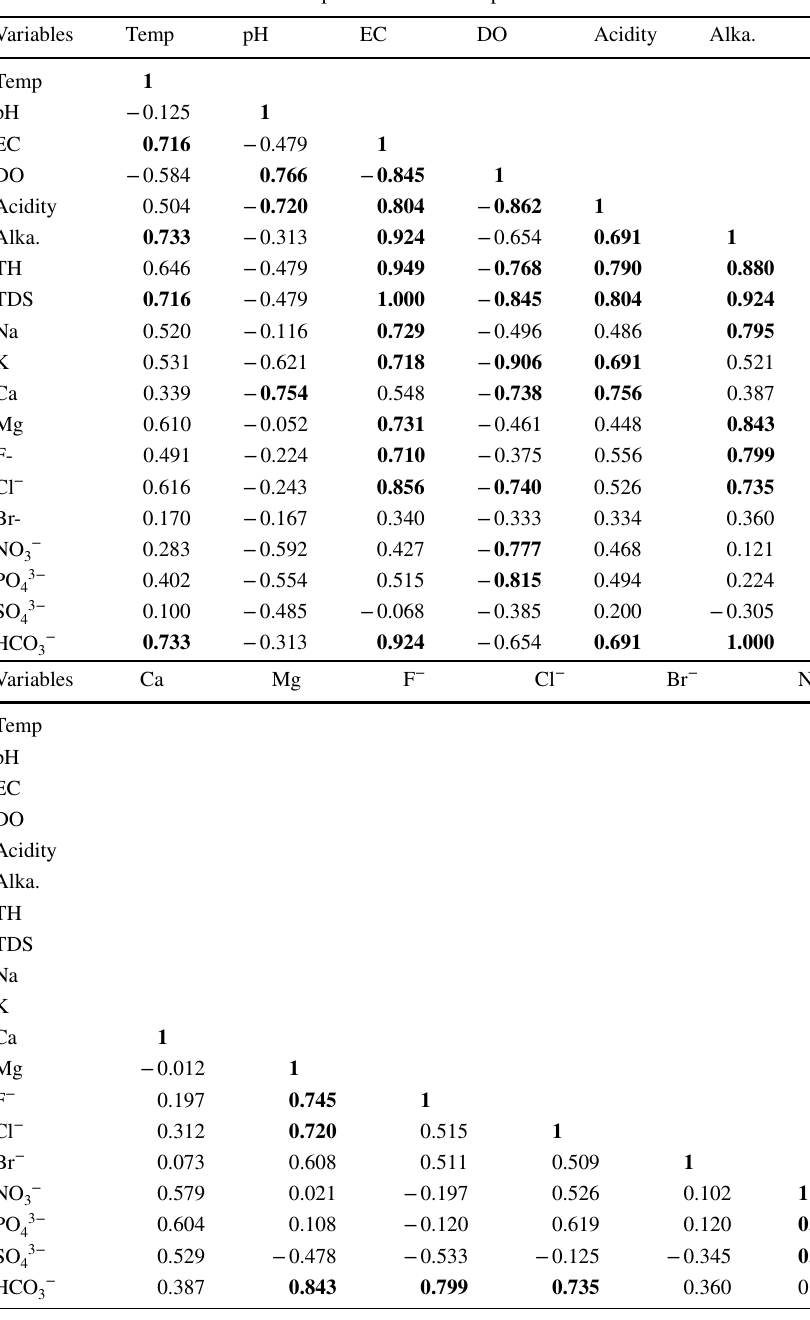
Values in bold are different from 0 with a significance level alpha